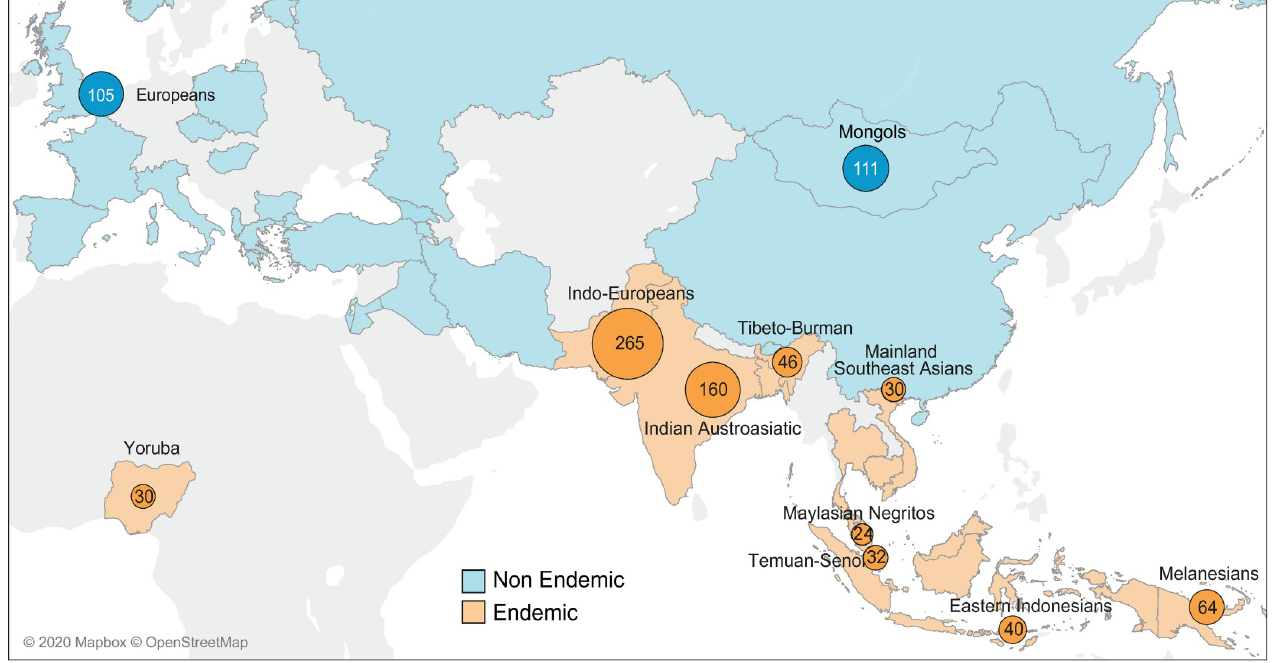
Fig 1. Geographic locations of the samples included in this study. The areas colored in blue and orange on the map represent countries where malaria is non-endemic and endemic, respectively, based on a WHO report (World Malaria Report 2018). The 11 population groups analyzed are represented by colored circles. The number in a circle is the number of samples. We used the Tableau v. 2021.2 to create the map images.